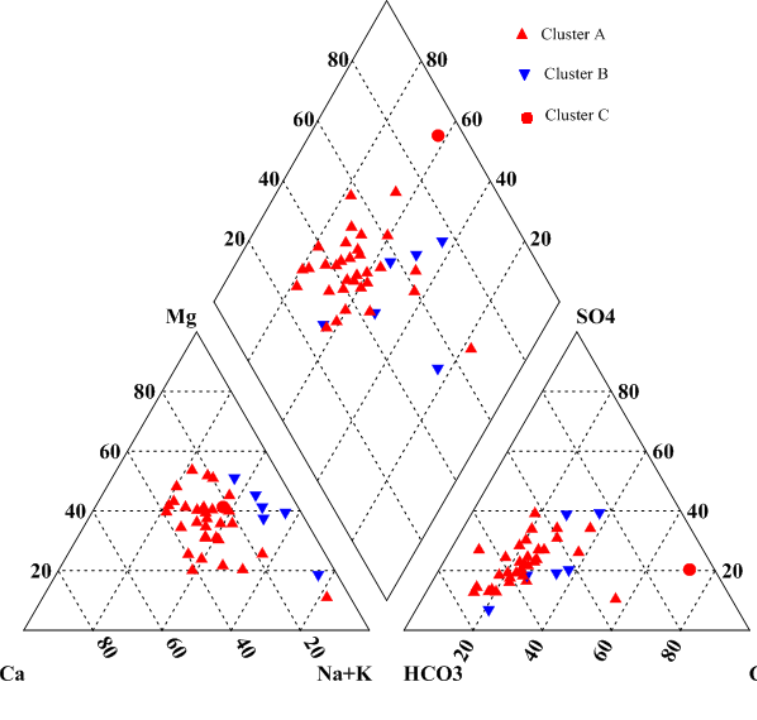
Figure 6. Piper diagram of phreatic water drawn with AquaChem